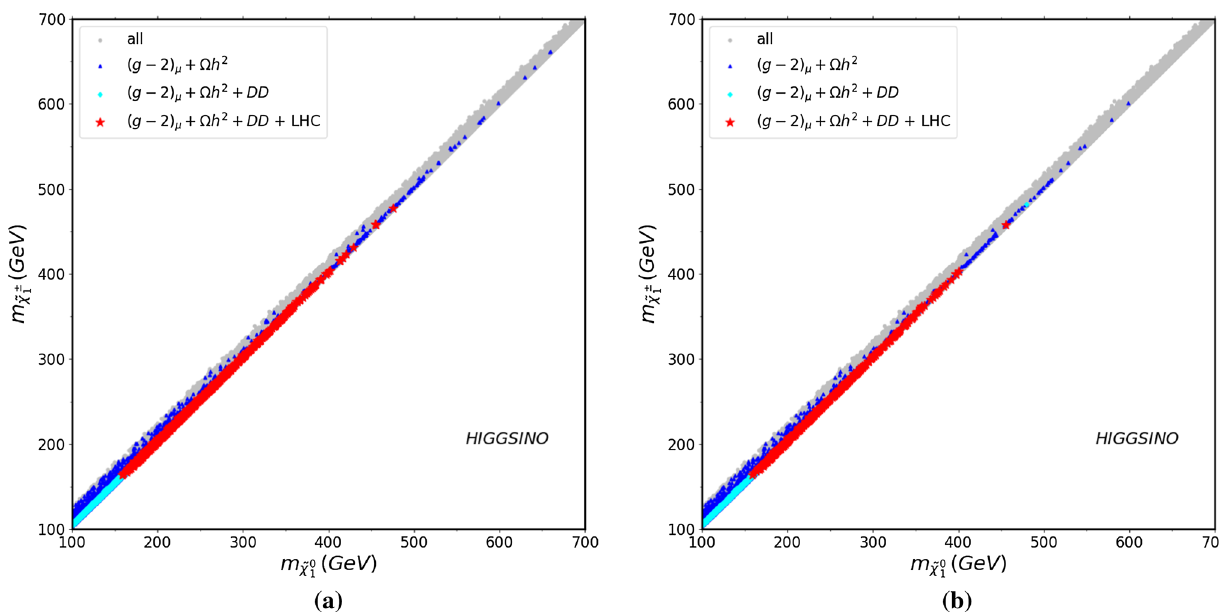
Fig. 1 The results of our parameter scan in the m ˜ χ 0 from ( g − 2 ) μ . For the color coding: see text